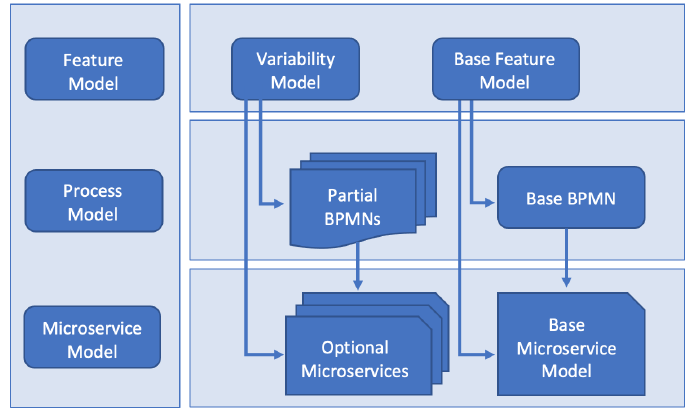
Figure 3. Models used in MSDeveloper.